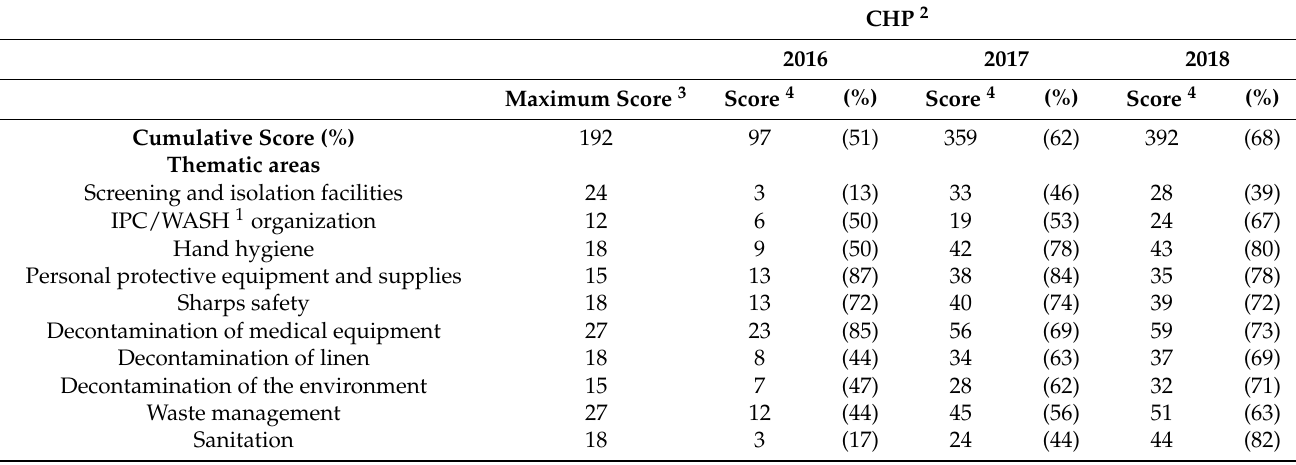
quarterly scores for the year (one quarter assessed in 2016; three quarters assessed in 2017 and 2018). Table 3. Average yearly compliance in relation to scores on a National IPC/WASH 1 assessment tool in Community Health Posts, Kenema district, Sierra Leone